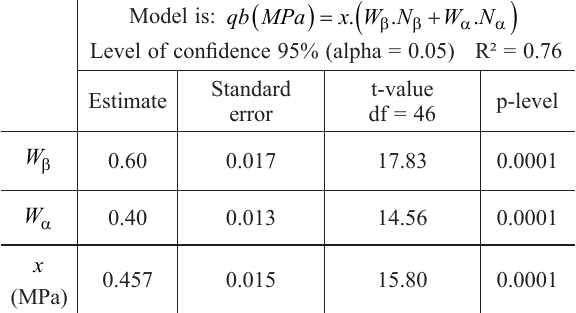
Table 3. Estimation of the relative contribution of the zones to the pile end-bearing